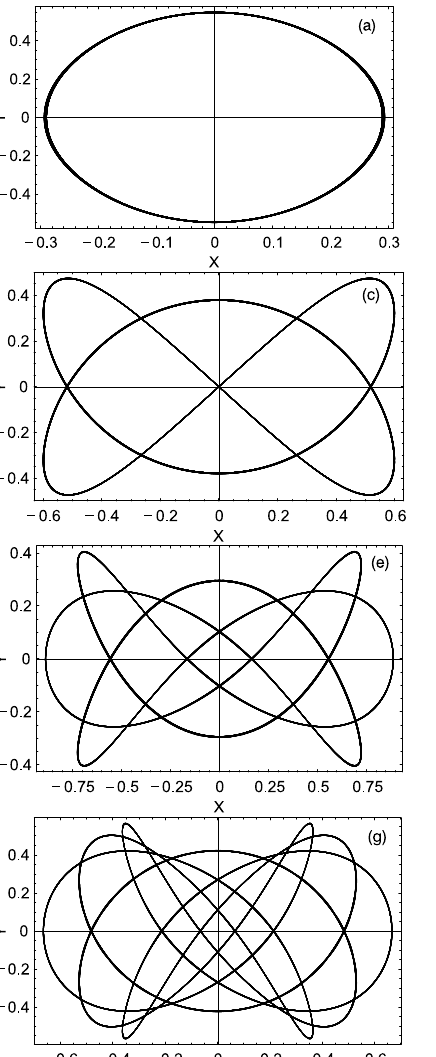
on the chaotic ocean and a time period of 10 5 time units was found to tend to the value 4.25. Furthermore, it is evident that this chaotic motion happens at high